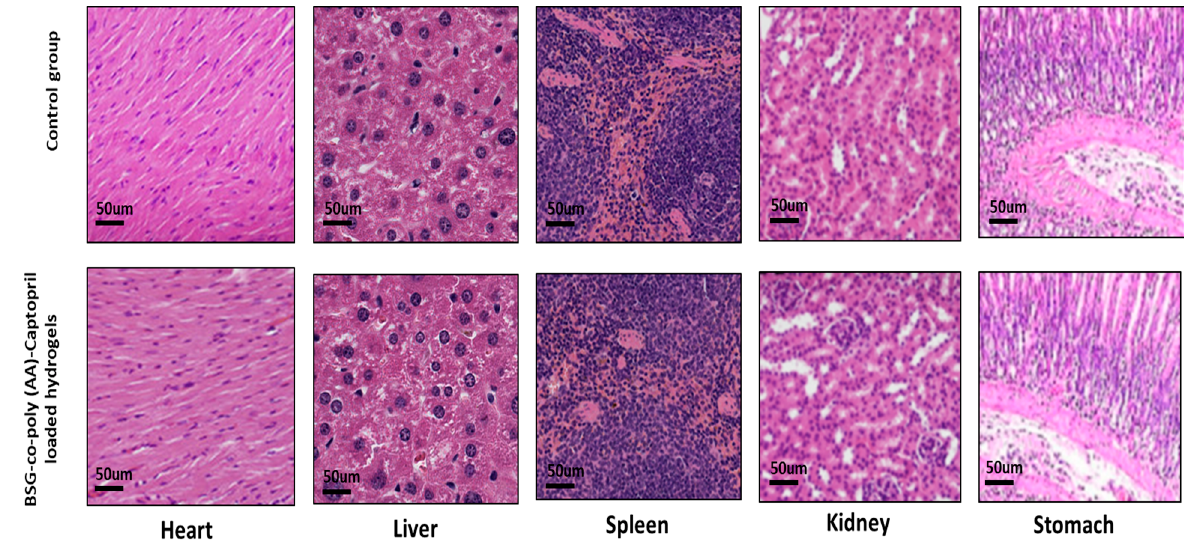
Figure 13. Histological analysis of control and BSG-co-poly (AA)-Captopril-loaded-hydrogel- treated group.